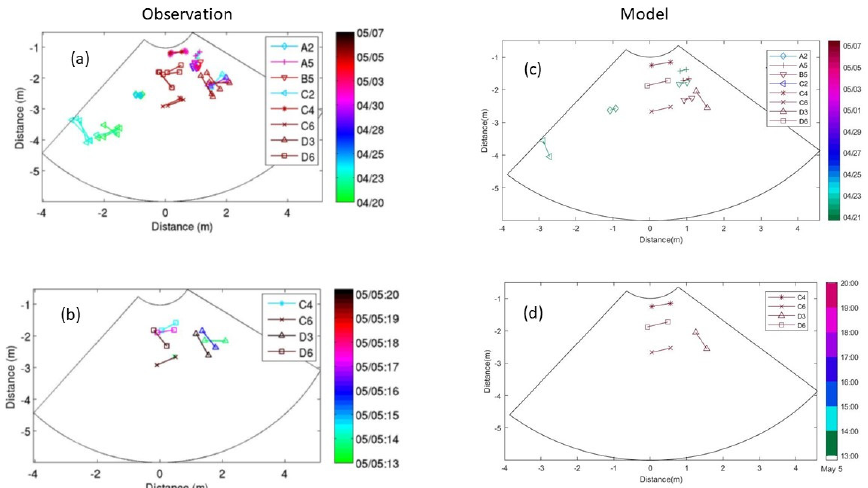
Figure 13. Positions for all visible objects at the shallow quadpod location up to the maintenance dive performed on 8 May: ( a ) observation for 20 April–7 May 2013; ( b ) observation for 13:00–20:00 on 5 May 2013; ( c ) model prediction for 20 April–7 May 2013; ( d ) model prediction for 13:00–20:00 on 5 May 2013. Note that Figure 13a,b were copied from [13]. The color bars denote the last time when each object was visible with dates for ( a , c ) and hour on 5 May for ( b , d ).